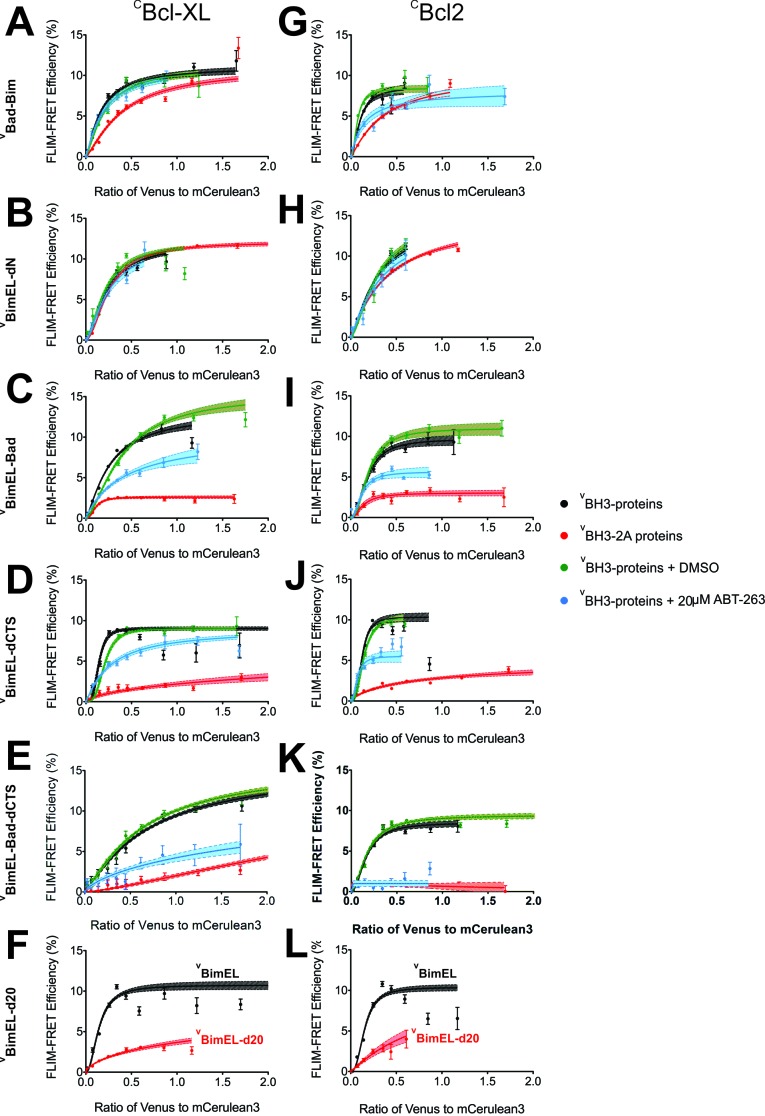
Mutations in the BH3 region and the Bim CTS impair Bim binding to Bcl-XL and Bcl-2.FLIM-FRET binding curves for the proteins indicated to the left of each row and (A–F) CBcl-XL or (G–L) CBcl-2 in MCF-7 cells illustrate the extent of binding for untreated (black) or DMSO treated controls (green), cells treated with 20 μM ABT-263 (blue) or cells expressing BH3-2A mutant BH3-proteins (red). Data points in FLIM-FRET binding curves correspond to the average FLIM-FRET efficiency for binned data (20 < cells/bin < 3,000). Error bars, SEM; shadowed area, 95% confidence interval for the best fit of the model to the data.10.7554/eLife.37689.020Figure 4—figure supplement 1—source data 1.Source data fit to a Hill equation to determine how mutations in the BH3 region and the Bim CTS impair Bim binding to Bcl-XL and Bcl-2.